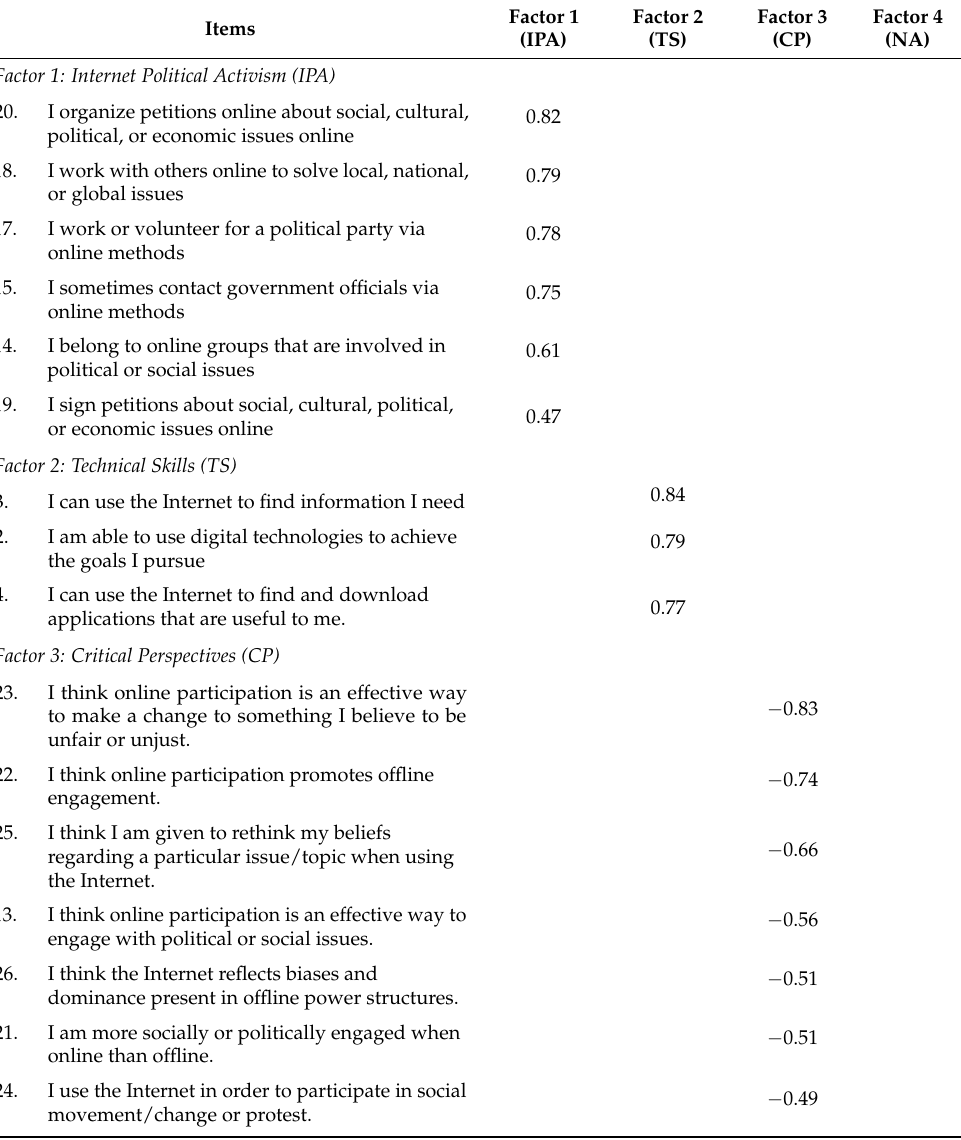
Table 2. Revised Digital Citizenship Scale (DCS-R) factor